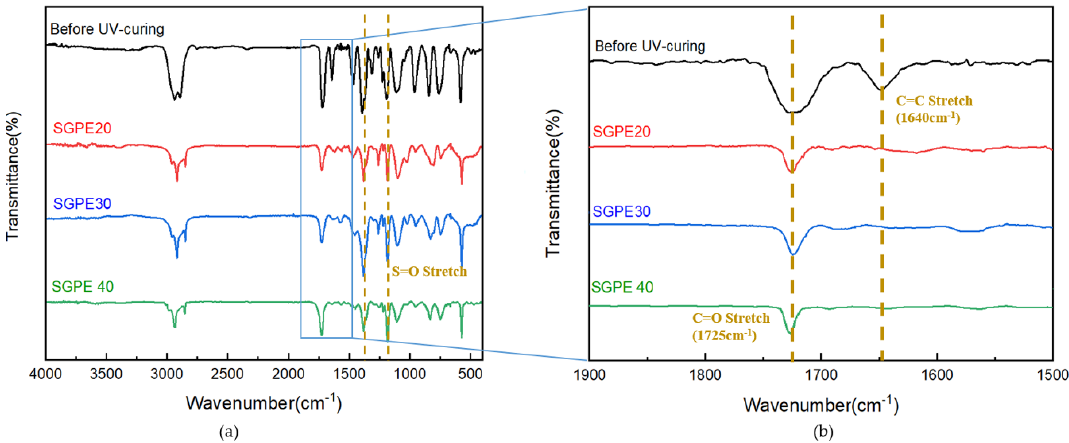
Figure 4. FT–IR spectra of ( a ) SGPEs before / after UV curing and ( b ) acrylic C = C bonds in the SGPEs Figure 4. FT – IR spectra of ( a ) SGPEs before/ after UV curing and ( b ) acrylic C=C bonds in the SGPEs before / after UV curing. before/ after UV curing.